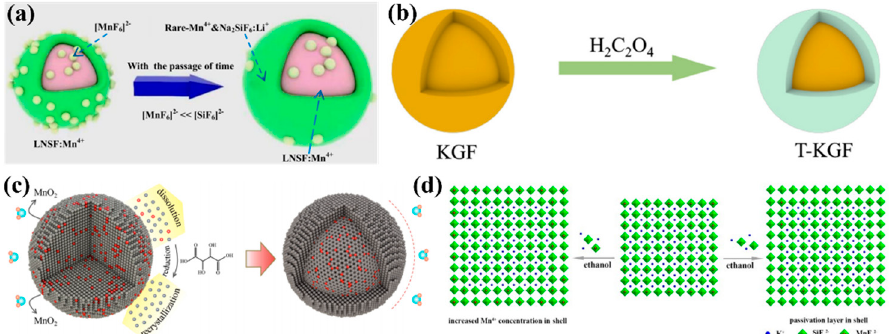
Figure 3. The model diagram of homogeneous core–shell structure formation. ( a ) LiNaSiF 6 : Mn 4+ (Reprinted from Ref [60]. Copyright from American Chemical Society, 2022); ( b ) T-KGF (Reprinted from Ref [53]. Copyright from Elsevier, Amsterdam, The Netherlands, 2018); ( c ) KSFM-RSRC (Reprinted from Ref [29]. Copyright from Elsevier, 2021); ( d ) K 2 SiF 6 : Mn 4+ (Reprinted from Ref [61]. Copyright from Royal Society of Chemistry, 2021).